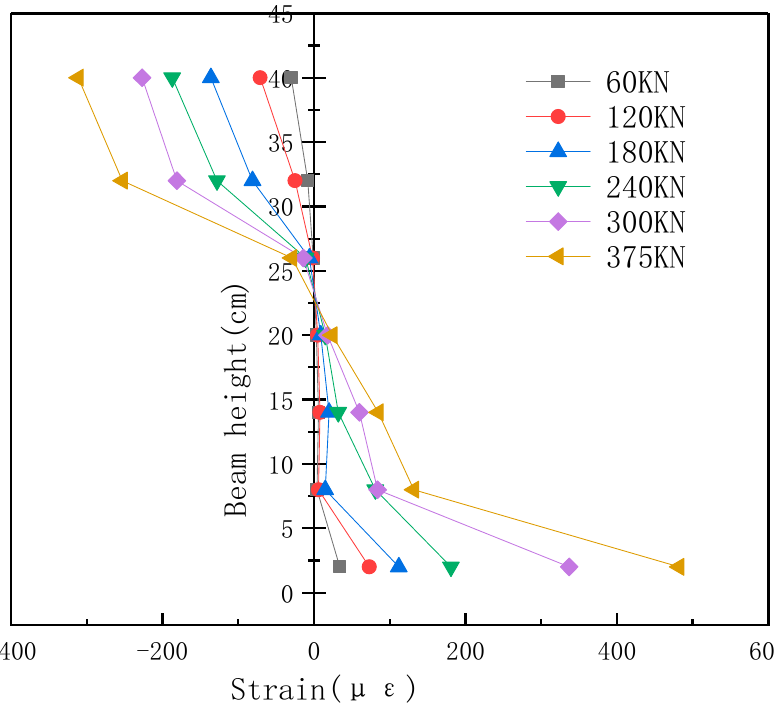
Figure 16. Strain of test beam L1 along beam height.